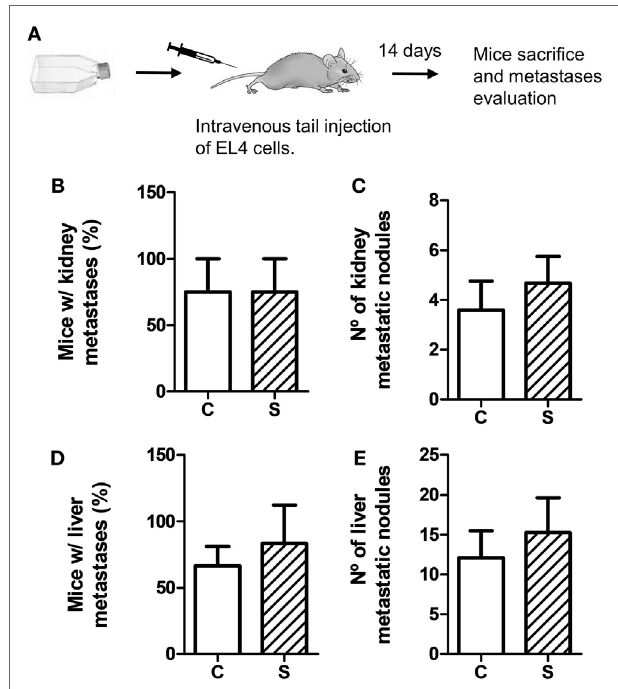
FigUre 3 | Experimental metastasis assay using EL4 cells. Experimental metastasis were evaluated 14 days after intravenous tail injection of 5 × 10 5 EL4 cells in mice subjected (S) or not (C) to chronic stress treatment. (a) Schematic representation of experimental protocol. Percentage of mice with metastatic nodules in kidney (B) or liver (D) was calculated. Number of metastatic nodules in kidney (c) or liver (e) was assessed. Results are the mean ± SEM of three independent experiments ( n = 4 mice per